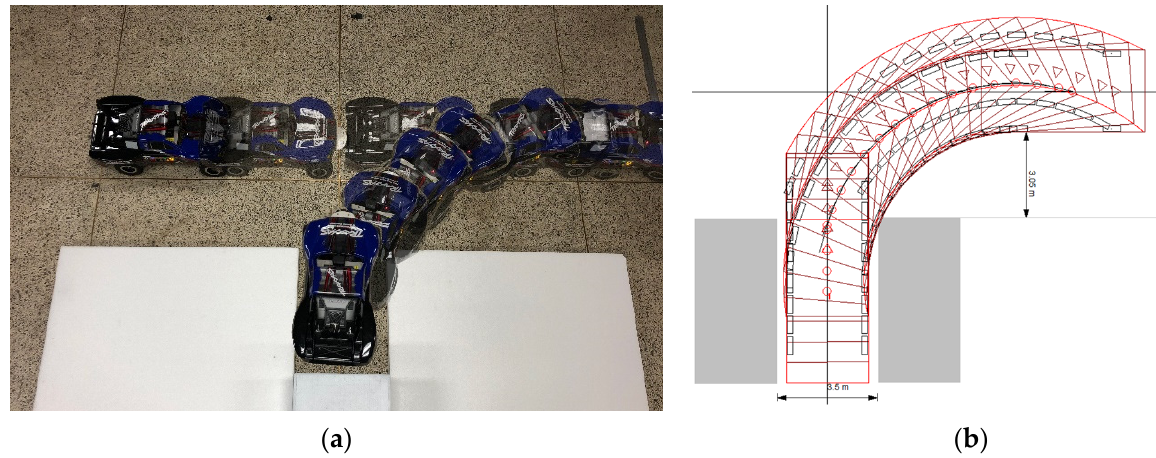
Figure 12. Failure of ( S + R − S − ) perpendicular parking with short separation ∆ Y : ( a ) Experimental parking test; ( b ) simulated parking path.